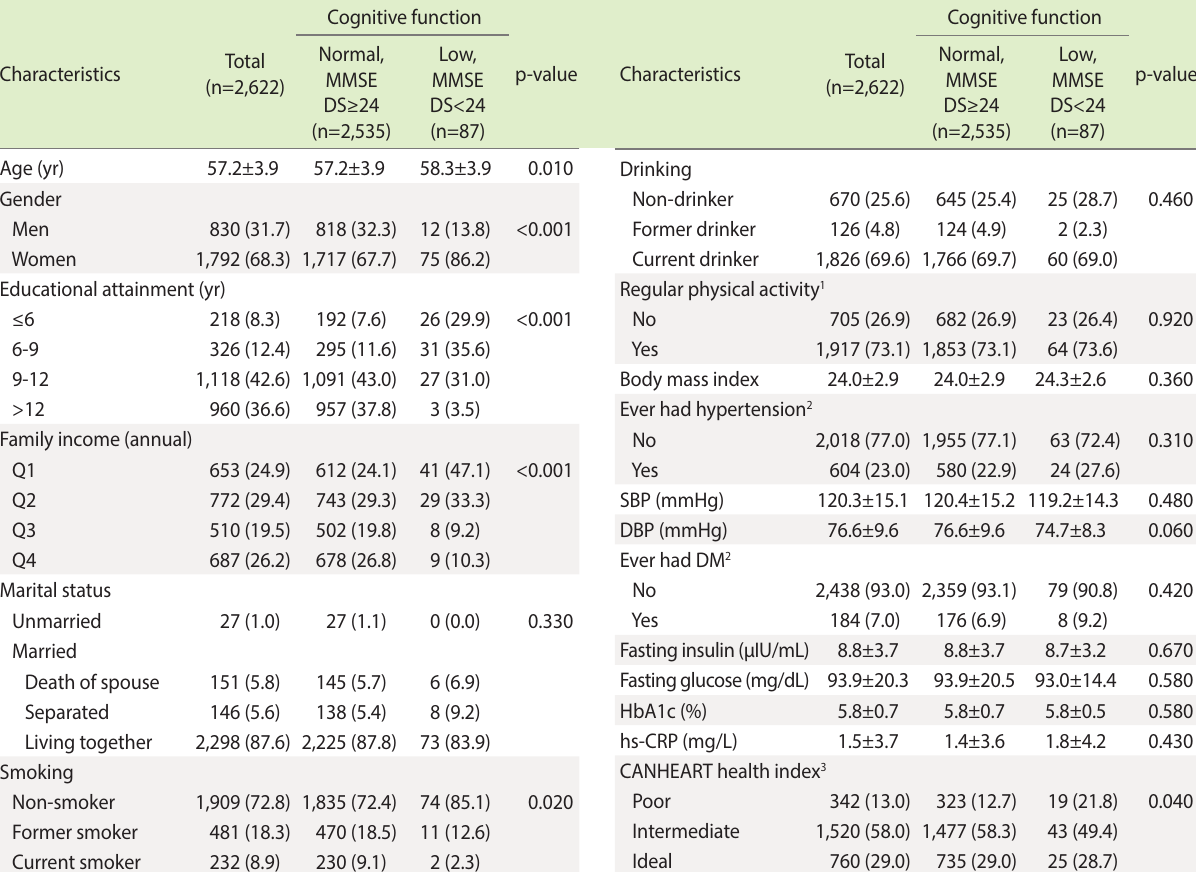
Table 1. Descriptive characteristics of study participants